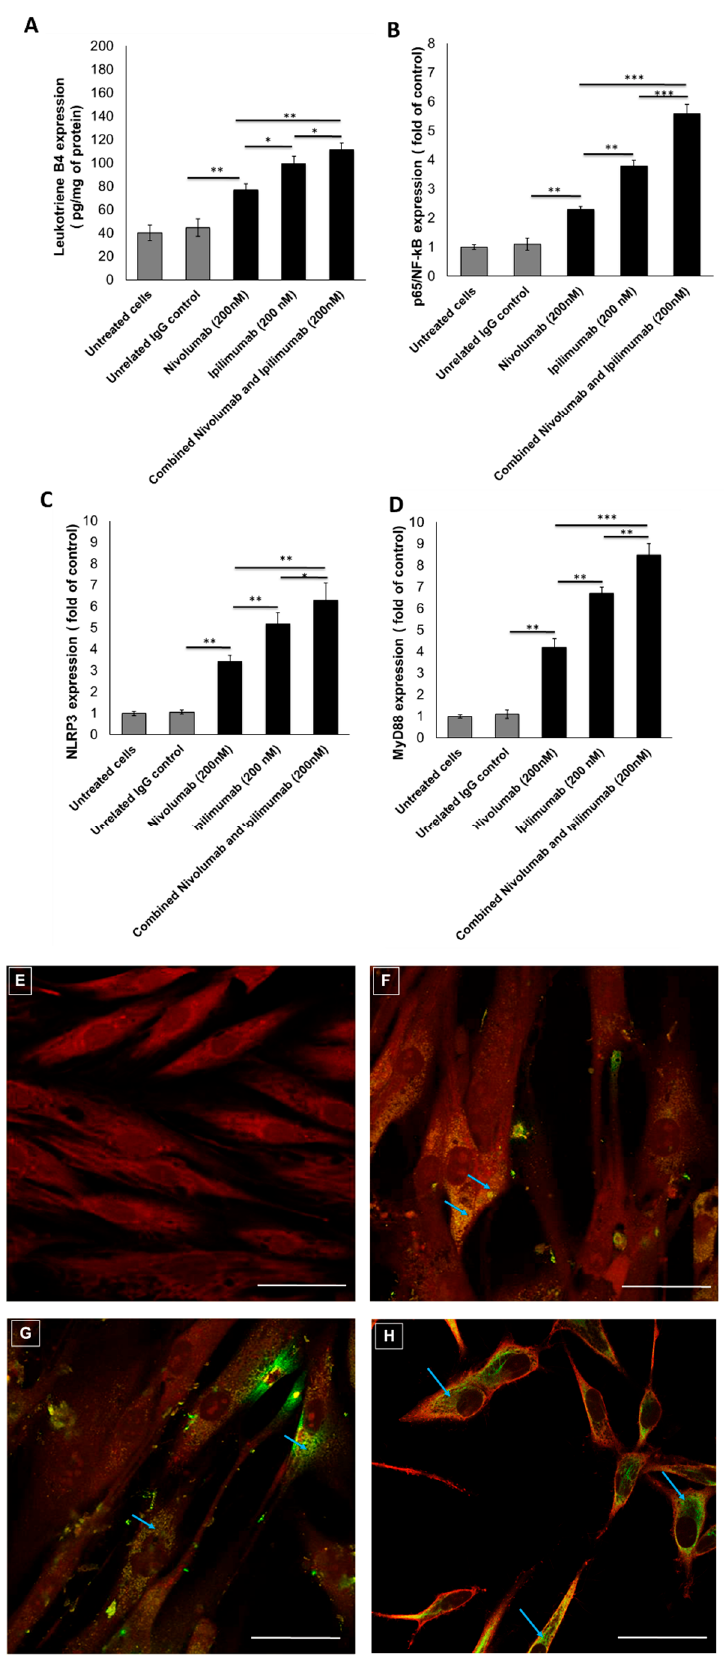
Figure 2. Pro-inflammatory effects of Nivolumab and Ipilimumab mAbs (alone or combined) on human cardiomyocytes co-cultured with hPBMCs. ( A ) Leukotriene type B4 production by HFC cells, treated with Nivolumab or Ipilimumab mAb alone (or combined) for 24 h, in the presence of